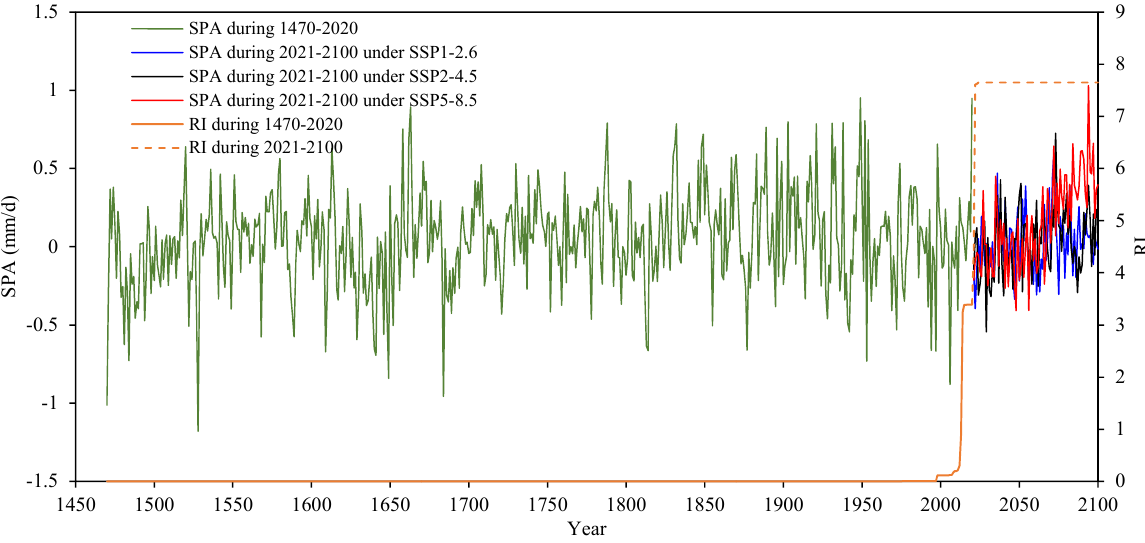
Figure 4. Evolution of the covariates of SPA and RI during the period from 1470 to 2100.